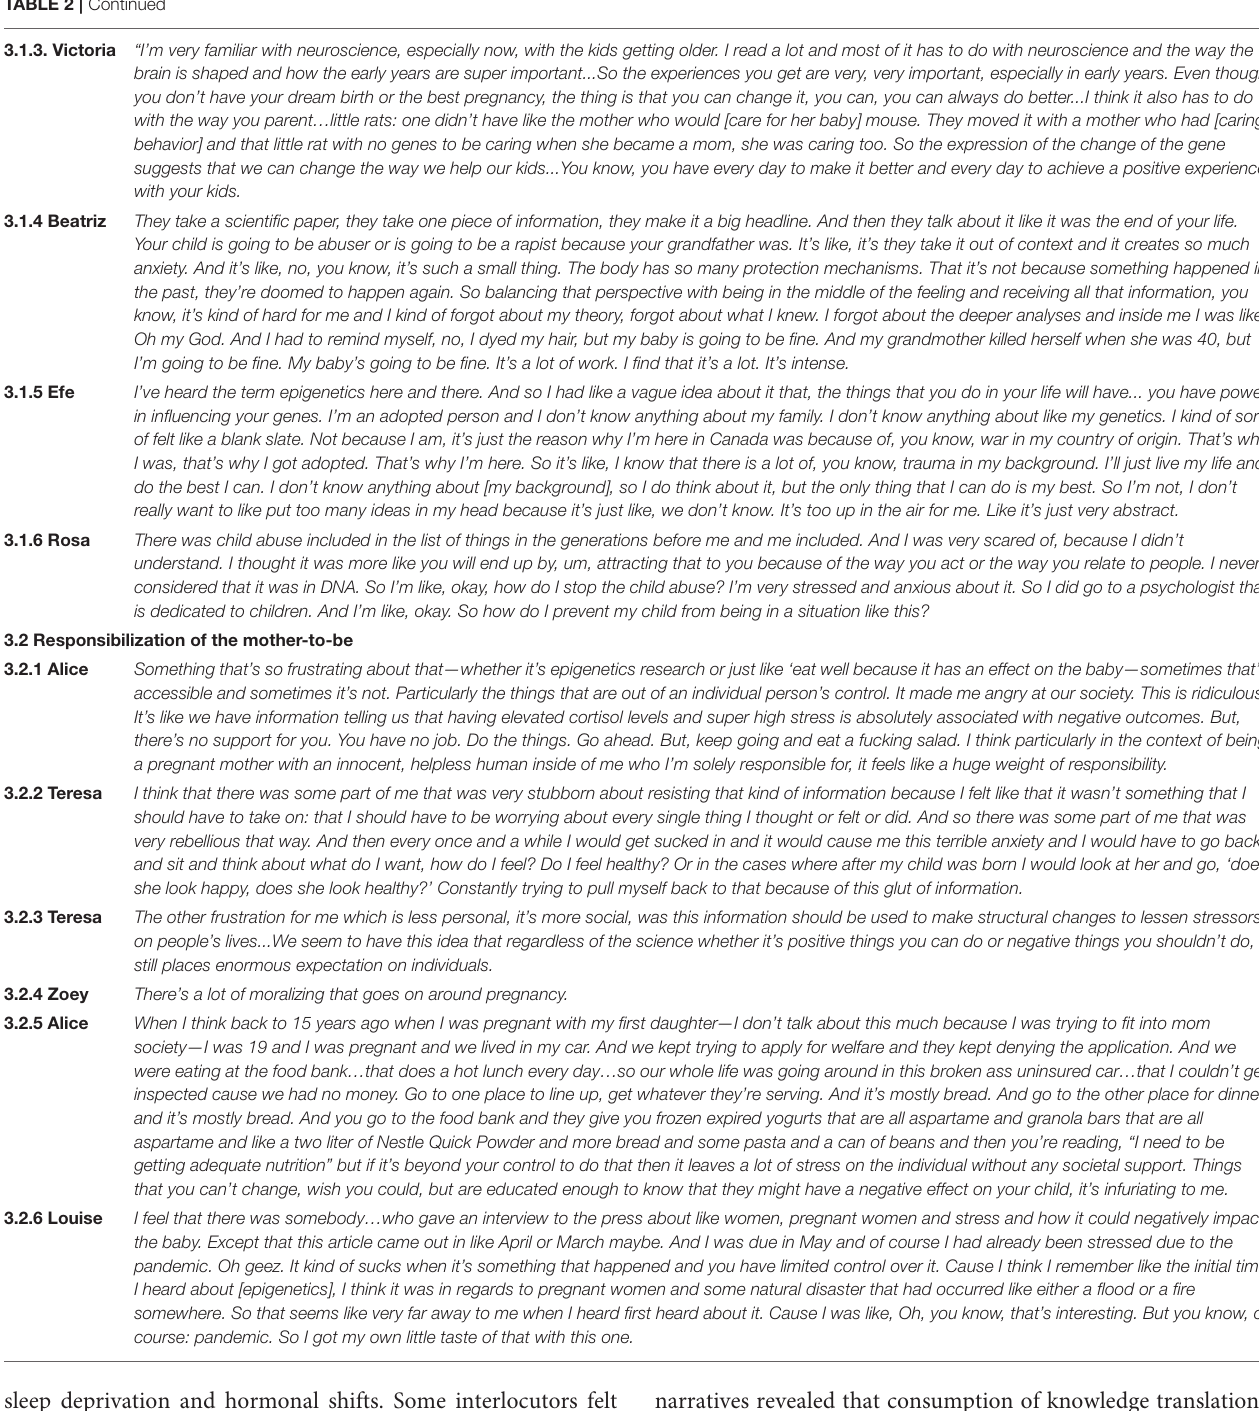
( Table 2.2 ) addresses several impacts of biomedical narratives on the expectations and the experience of the perinatal period. Women discussed their engagements with translations of epigenetics and neuroscience as anxiety-inducing. Participant